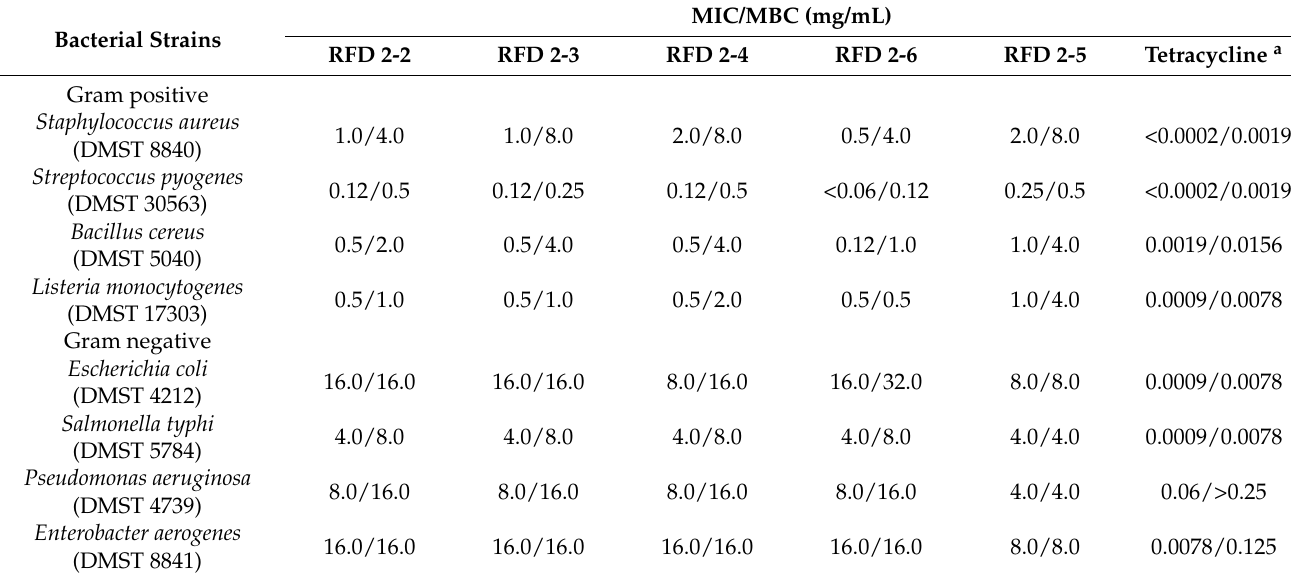
Table 4. The MIC and MBC of five eucalypt oils against eight bacterial